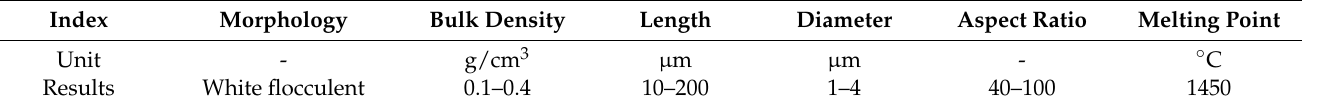
Table 4. Physical characteristics of ACSW.